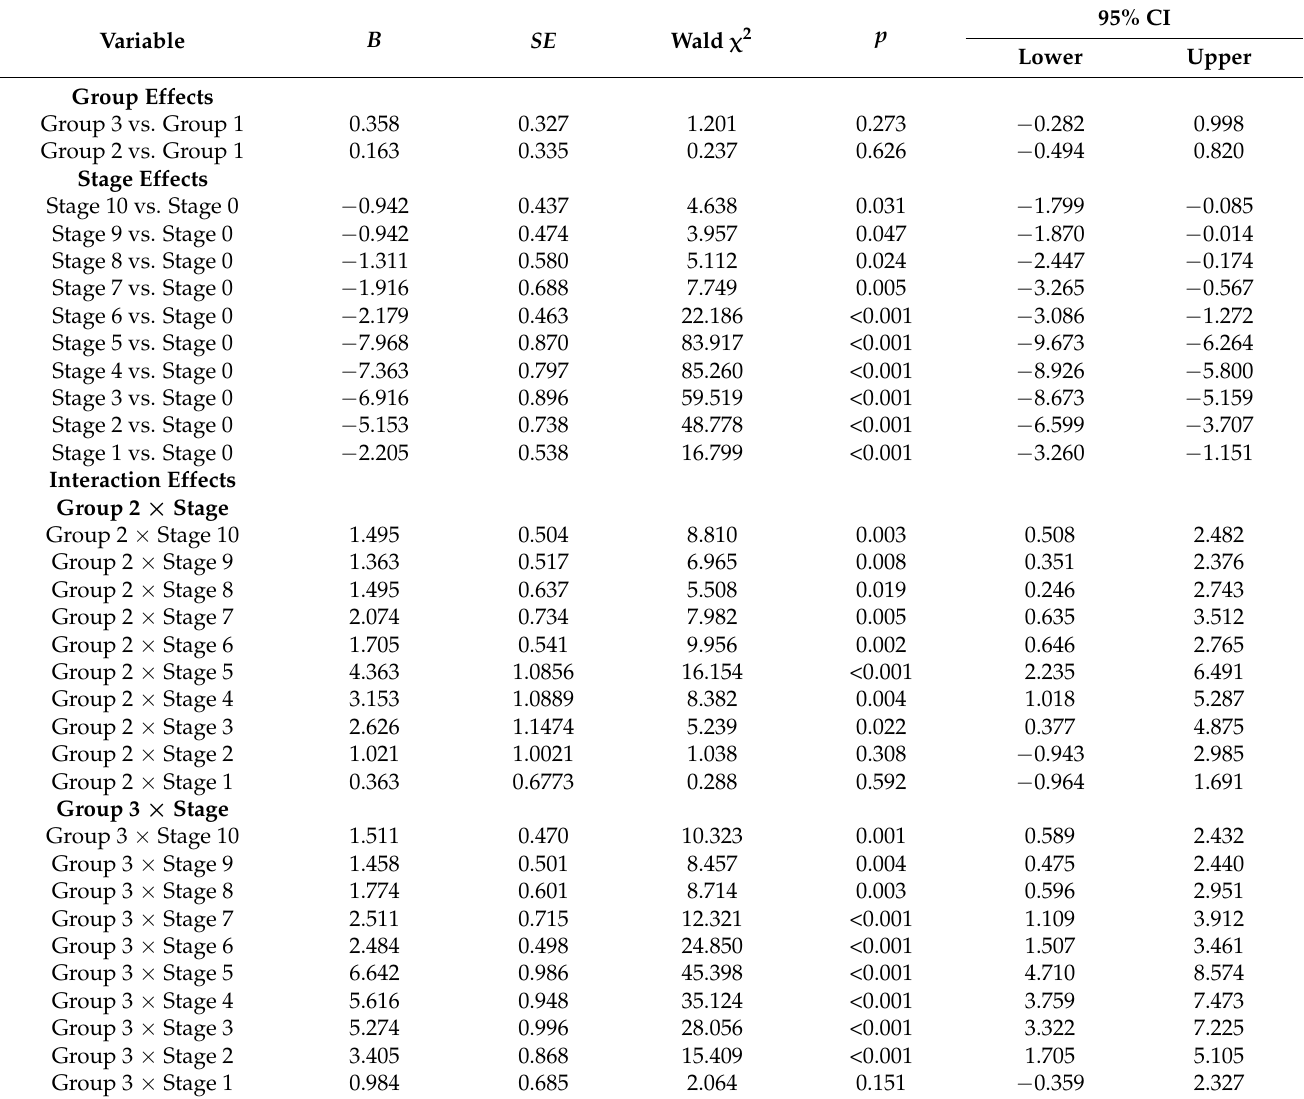
Table 3. Comparisons of changes in oxygen saturation (SpO 2 ) for neonates in the three treatment groups across the 11 stages of the heel-prick procedure: analysis using generalized estimating equation with multiple linear